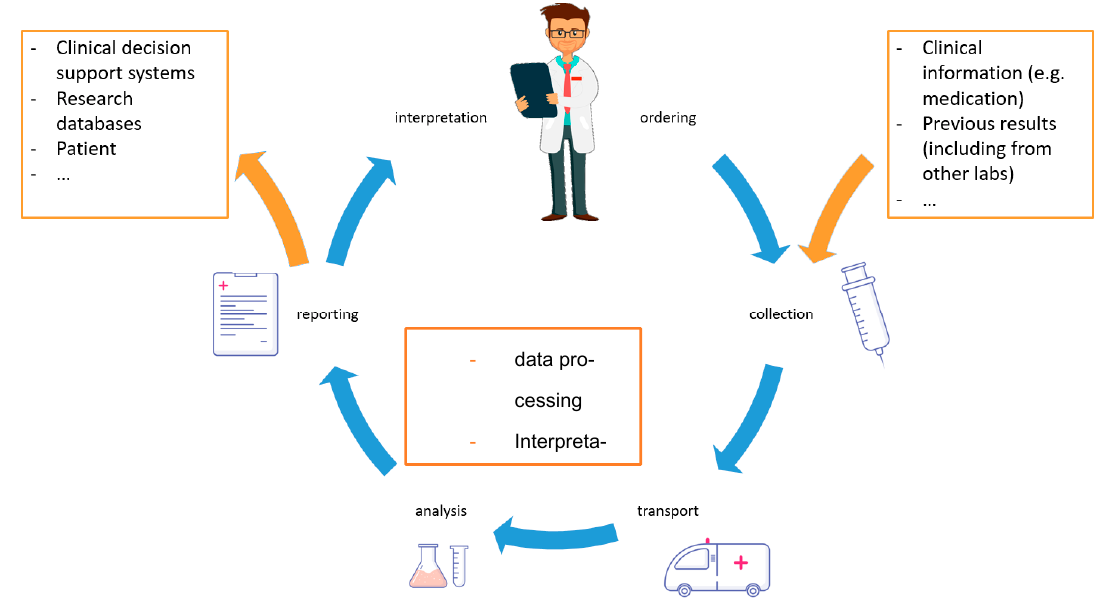
Figure 1. The classical brain-to-brain loop [27] describing the total testing process from the selection of the test to the return of the final result is expanded in interconnected health care systems. The laboratory electronically receives additional information besides the test order. On this basis, the laboratory can generate high-quality interpretations and comments of the results. The recipient of the report is no longer the treating physician but also electronic applications and patients themselves.